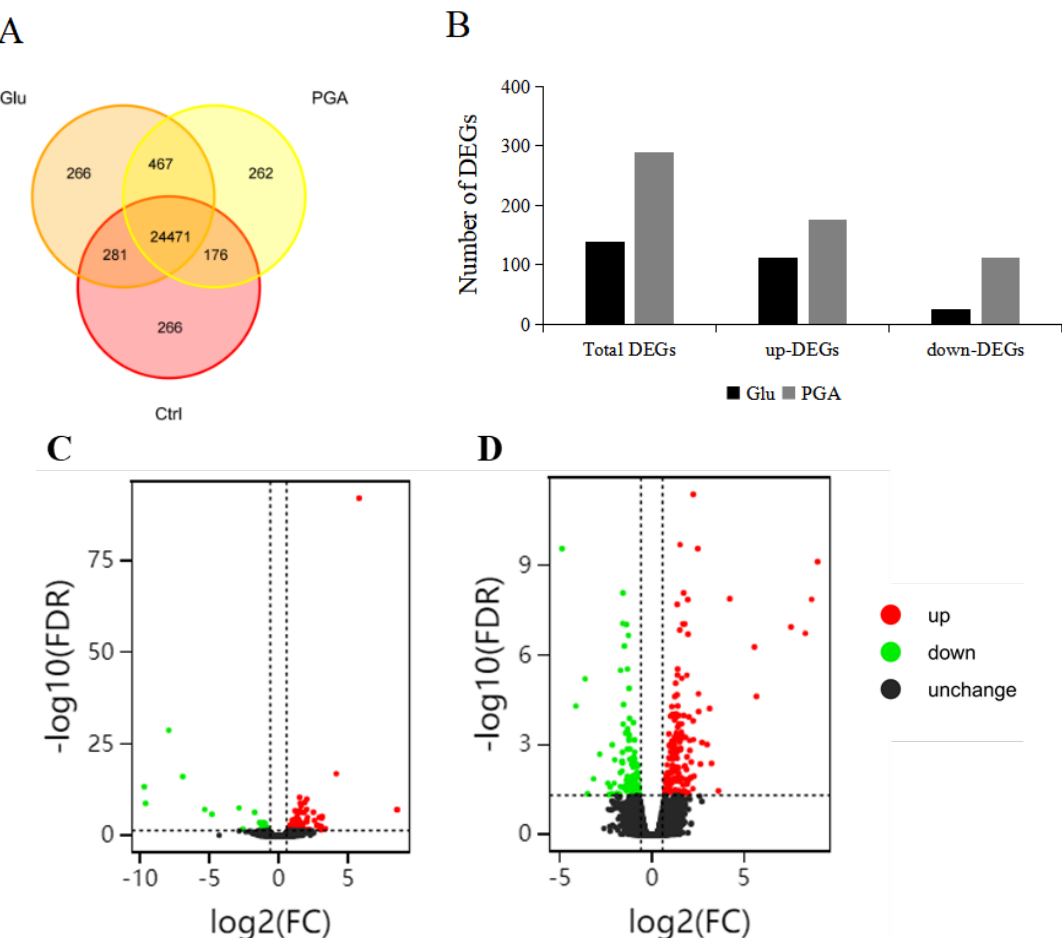
Figure 4. ( A ) Venn diagram of expressed genes in Glu- and γ -PGA-primed plants under heat stress; ( B ) number of differential genes; ( C ) the volcanic plot of Glu DEGs relative to Ctrl.; ( D ) the volcanic plot of γ -PGA DEGs relative to Ctrl. X-axis depicts fold change in gene expression where, the smaller the value, the higher the expression relative to Ctrl. Y-axis denotes false discovery rate where, the bigger the value, the smaller the ratio of the number of false positives to the number of total positives. Red and green dots represent significantly up-regulated and down-regulated DEGs, respectively. Black dot indicates genes that were not differentially expressed.